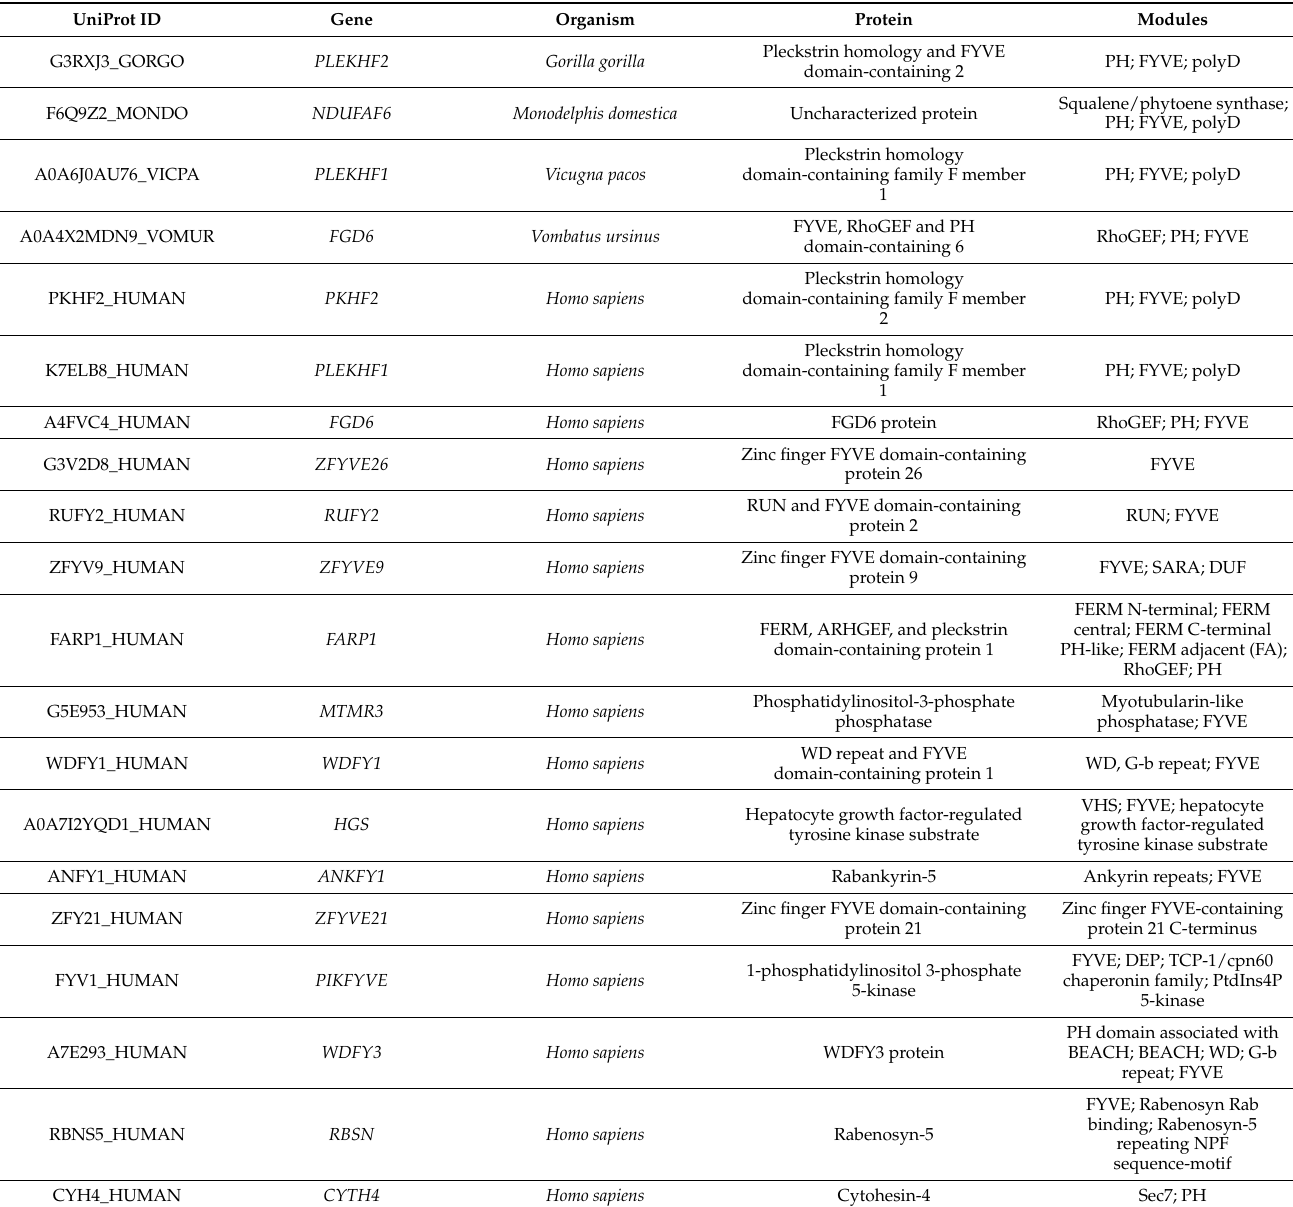
Table 2. Different modules found in mammalian Phafin2 and PH-, FYVE-, and polyD-containing